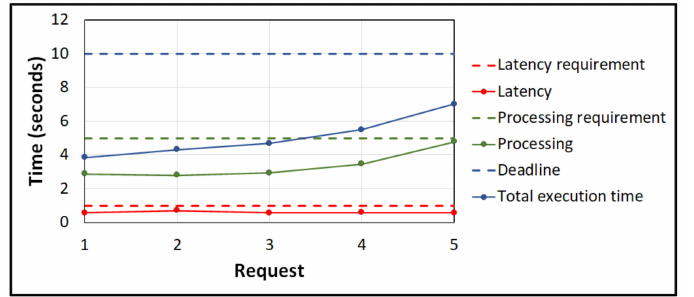
Figure 5. Latency, processing and total execution times of requests using ESCOVE.